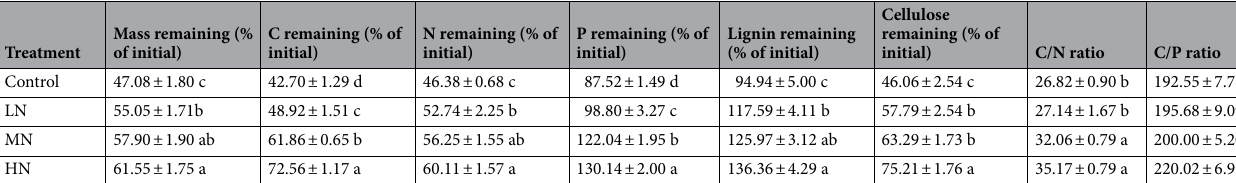
Table 1. Chemical properties of leaf litter in different N deposition treatments after 1 year of decomposition. Values are expressed as mean ± SE (n = 3). Values marked with different letters are significant ( P < 0.05). LN simulated low nitrogen deposition; MN simulated medium nitrogen deposition; and HN simulated high nitrogen